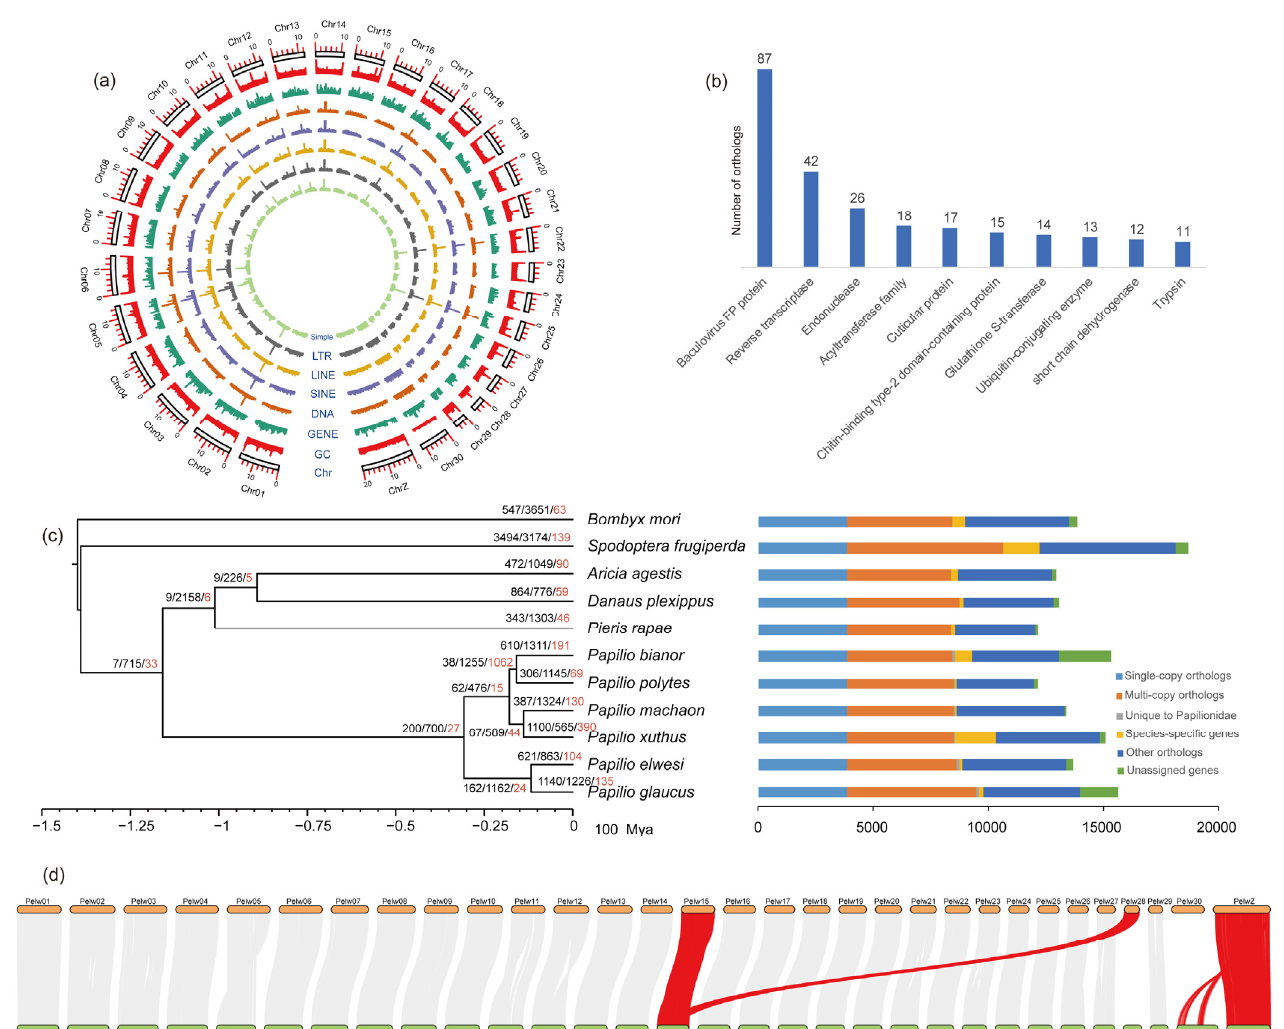
Figure 1. Genome characteristics, phylogeny, gene family evolution of Papilio elwesi , and interspecific synteny. ( a ) Genomic characters of each chromosome with its length (Chr), GC content (GC), protein-coding genes density (Gene), repetitive elements of DNA transposons (DNA), long interspersed nuclear elements (LINE), short interspersed nuclear elements (SINE), long terminal repeat elements (LTR), and simple repeats (Simple). ( b ) Phylogeny and gene family changes of 11 lepidopteran species. The values show the number of expanded, contracted, and significantly rapid evolutional (red) gene families of nodes and species. ( c ) The top 10 gene families with significant expansions. ( d ) Chromosomal synteny between Papilio elwesi (Pelw) and Papilio machaon (Pmac).